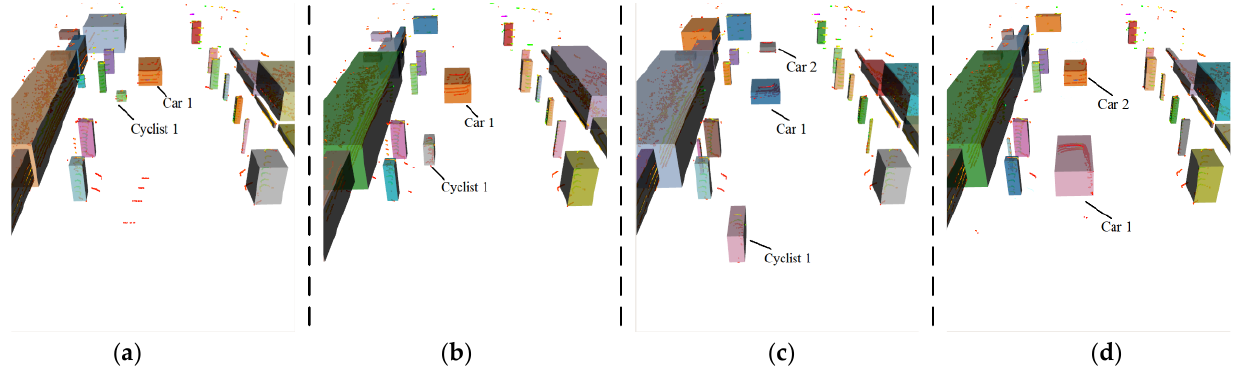
Figure 16. Continuous detection of Euclidean clustering: ( a ) 2.5 s; ( b ) 5.0 s; ( c ) 7.5 s; ( d ) 10.0 s.